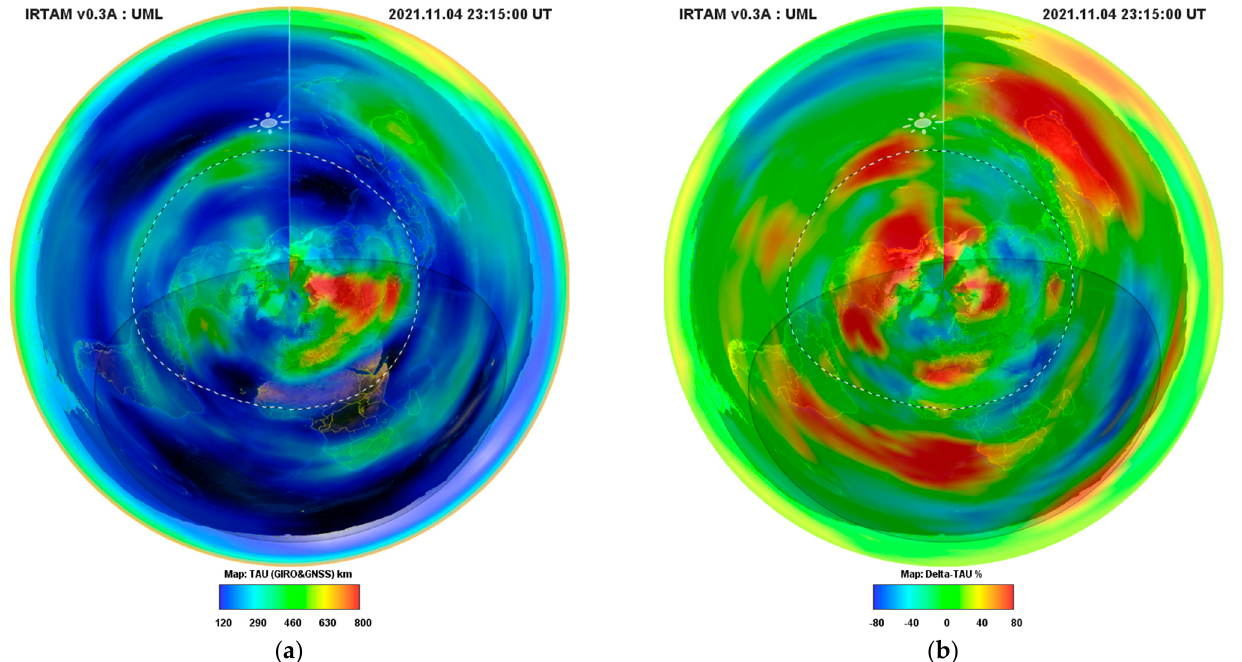
Figure 6. Global maps of effective slab thickness: ( a ) weather nowcast of EST using coordinated GIRO and GNSS capability, and ( b ) EST “anomaly” map of deviations from the quiet − time expected behavior. The dashed line is the magnetic equator, and the shaded area corresponds to nighttime.